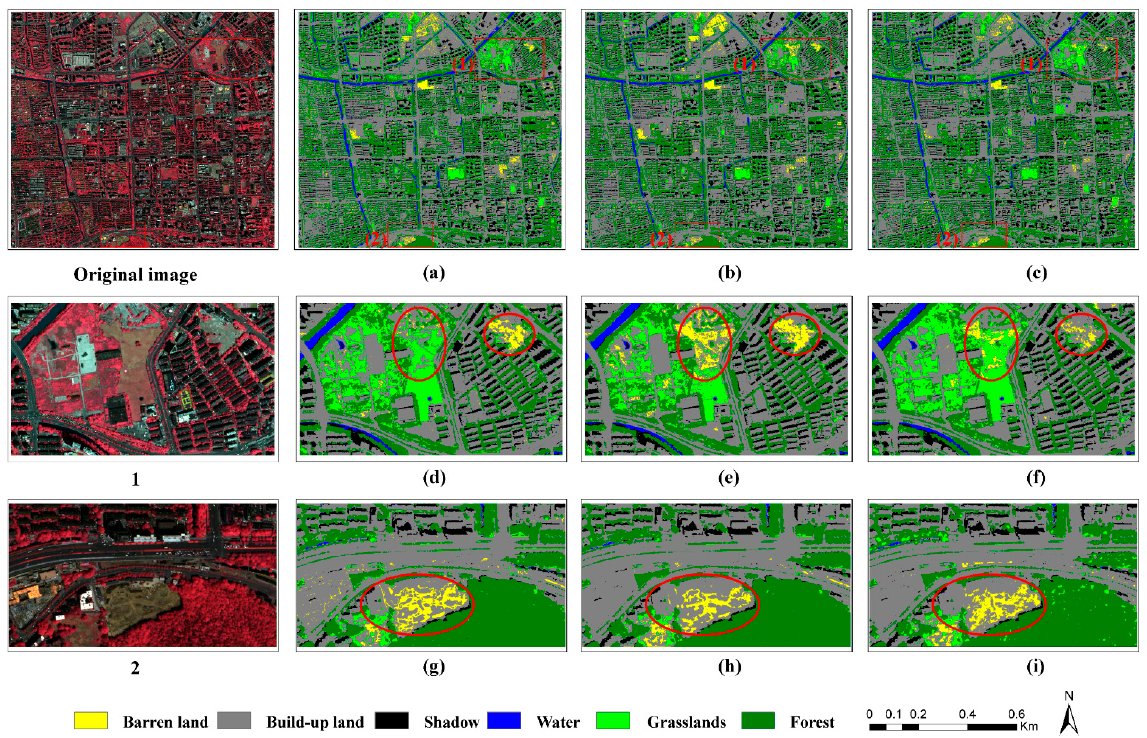
Figure 7. Optical classification results of the three AL methods when the “preferred feature” combination was used: ( a ) BBLC; ( b ) BBM; ( c ) BBE. And two subsets classification diagram (Subset (1) and Subset (2)). Subset (1): ( d ) BBLC; ( e ) BBM; ( f ) BBE. Subset (2): ( g ) BBLC; ( h ) BBM; ( i ) BBE.